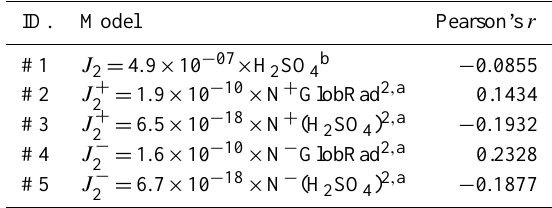
Table 2. Origins of air masses reaching the puy de Dˆome sampling site. 123 days could not be studied because of lack of data to run the Hysplit